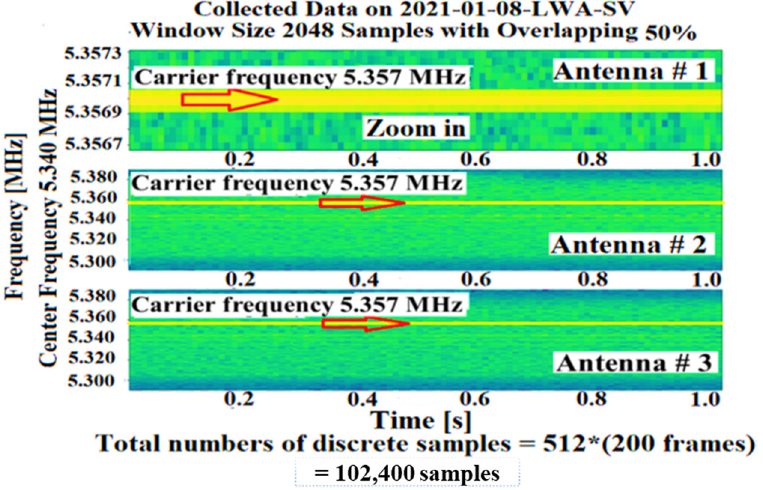
Figure 5. A waterfall plot of LWA-SV antenna representing a carrier wave across a frequency range. The color indicates its amplitude demonstrated over time and zooms in for antenna one.